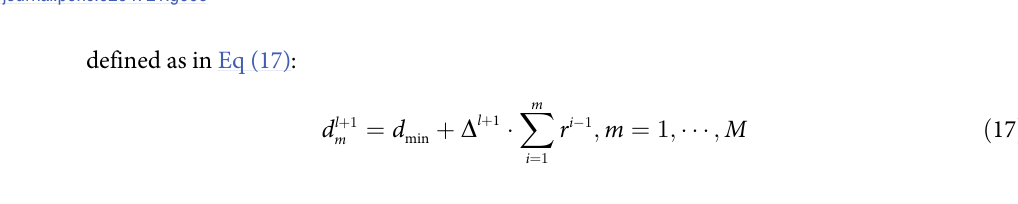
Fig 6. The non-uniform depth sampling strategy. R l +1 is the total range of search and Δ l +1 is the initial depth interval. The number of hypothetical depth planes M at different stages is 64, 32, and 8.